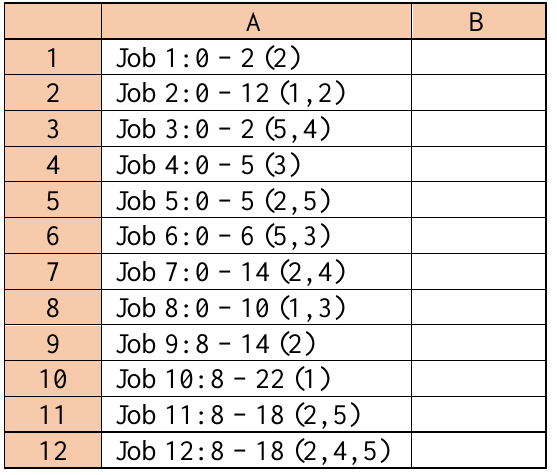
Fig. 3. Fragment of jobs